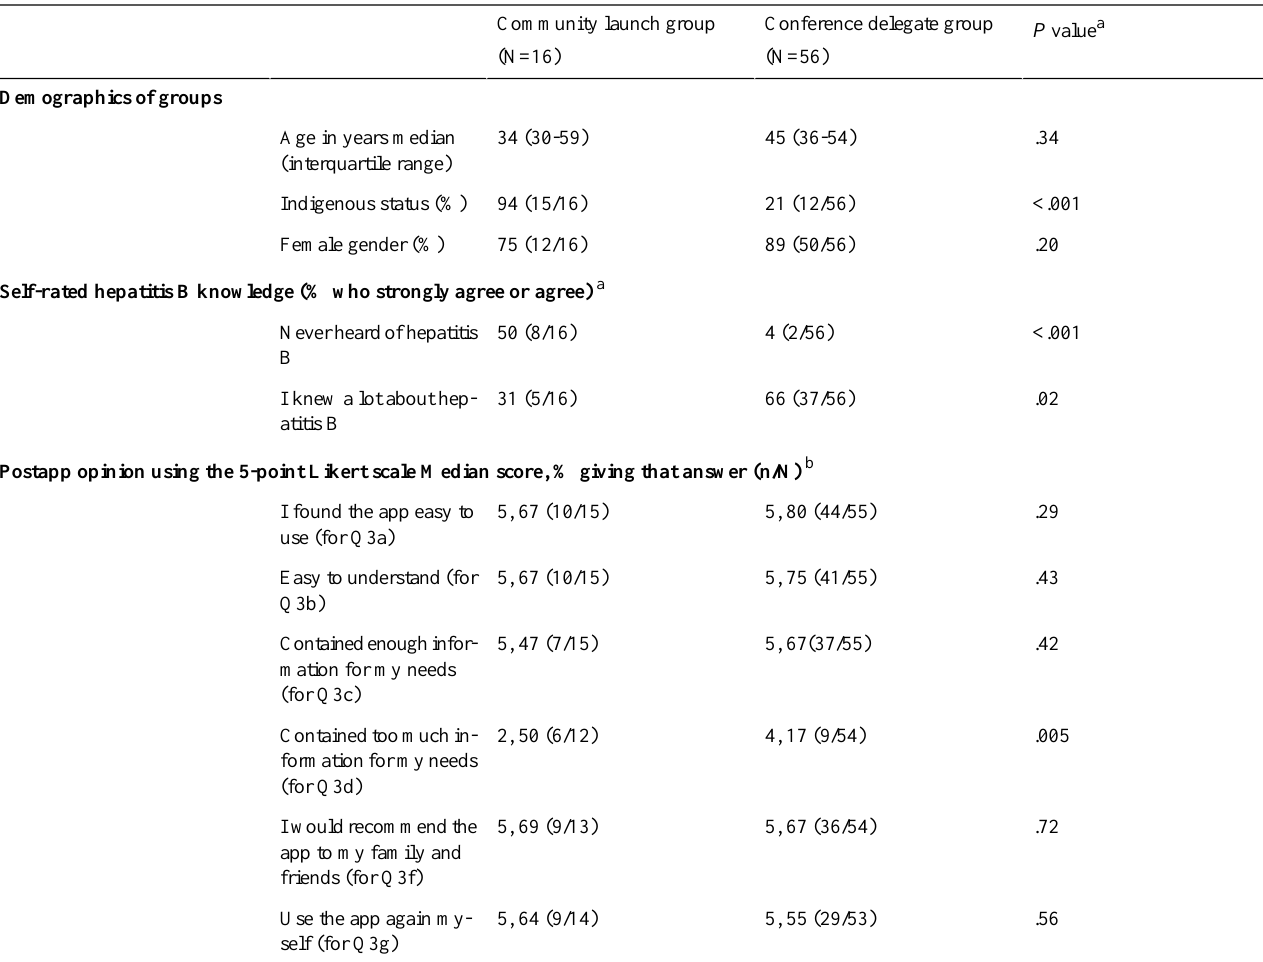
Table 1. Demographics of participants and results of the opinion-based component of the evaluation